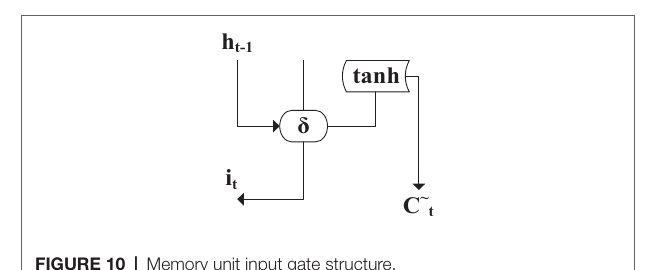
FIGURE 10 | Memory unit input gate